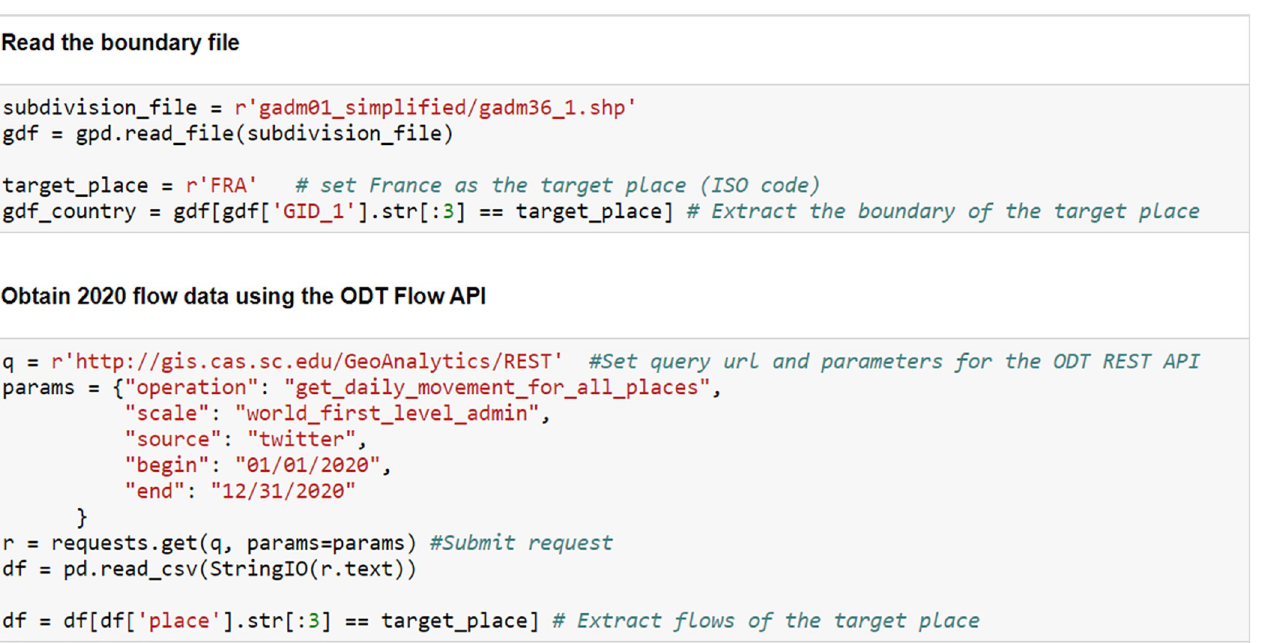
Fig 13. Sample codes of reading the boundary file (for mapping) and obtaining human mobility data using the ODT Flow API.